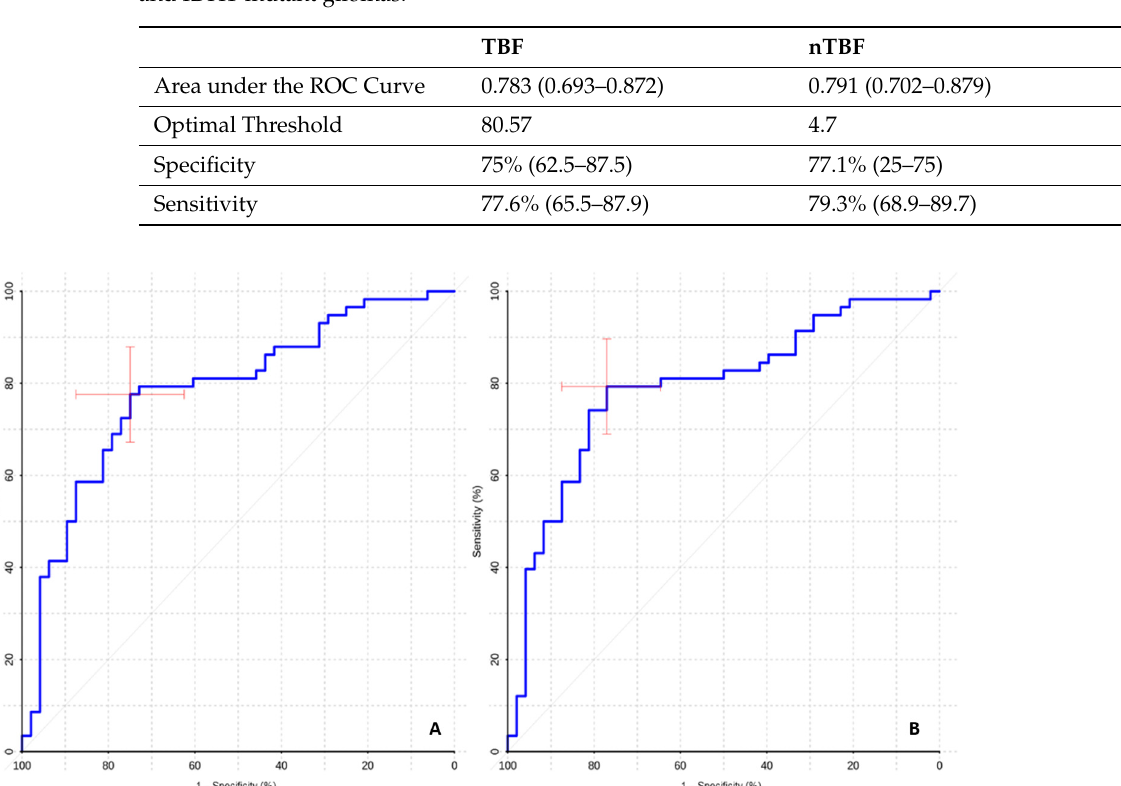
Figure 3. ROC curves. Comparison of maximum blood flow ( A ) and maximum normalized blood flow ( B ) between groups of wildtype and IDH1-mutant